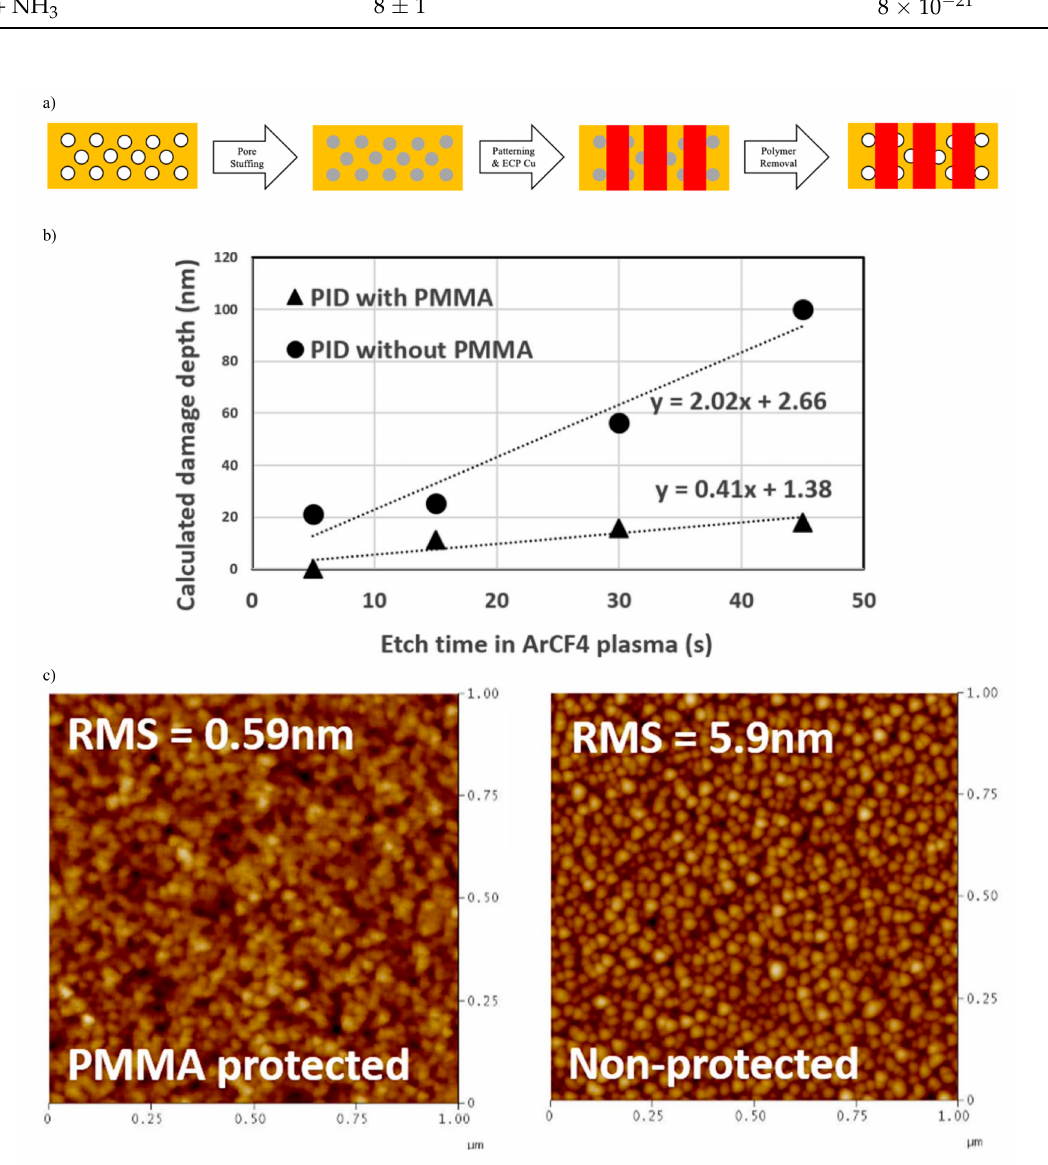
Figure 11. ( a ) Schematic description of the dual damascene process via P4 approach; ( b ) Penetration of Ar/CF4 plasma- induced damage for both stuffed and non-stuffed p-OSG; ( c ) Surface roughness by AFM for stuffed and non-stuffed samples after Ar/CF4 plasma etch. Note that stuffed sample received additional thermal un-stuffing process before AFM